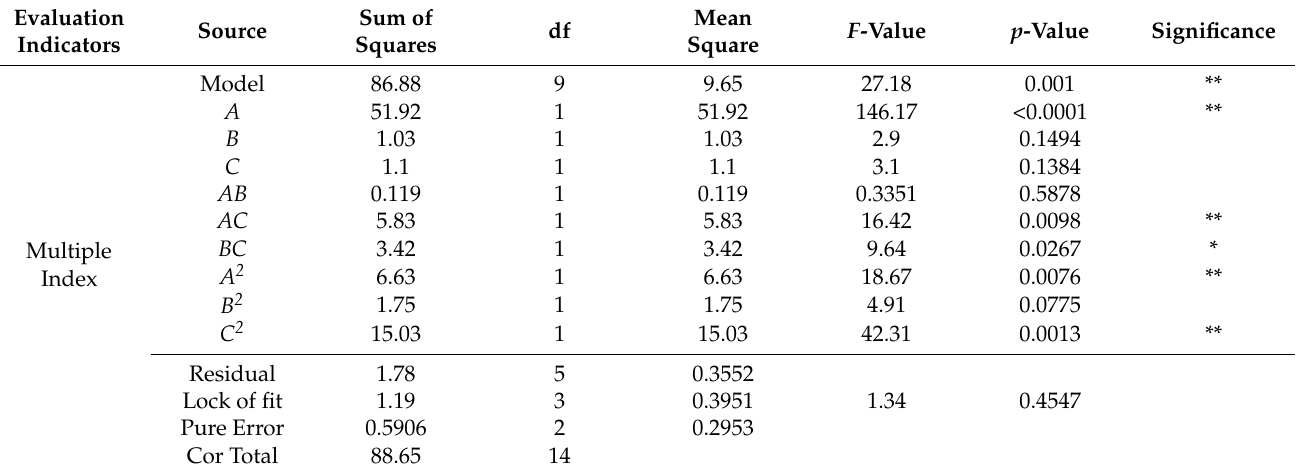
Table 5. Analysis of variance for the multiple index.